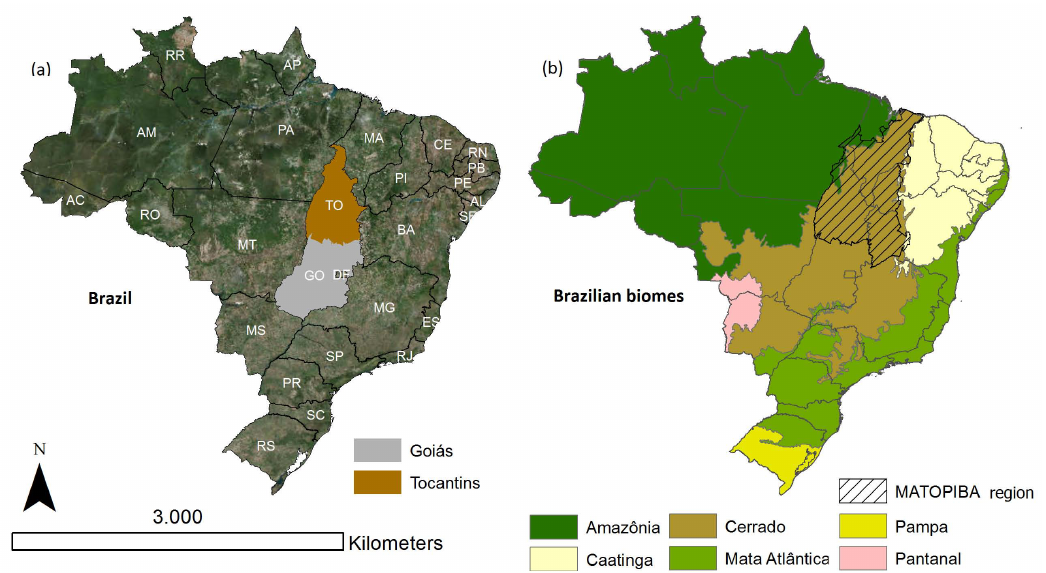
Figure 1. The Brazilian maps highlight: ( a ) the two States where fieldwork and other data analyses were conducted; ( b ) the biomes distribution over the territory, and the Maranh ã o, Tocantins, Piau í , and Bahia (MATOPIBA)